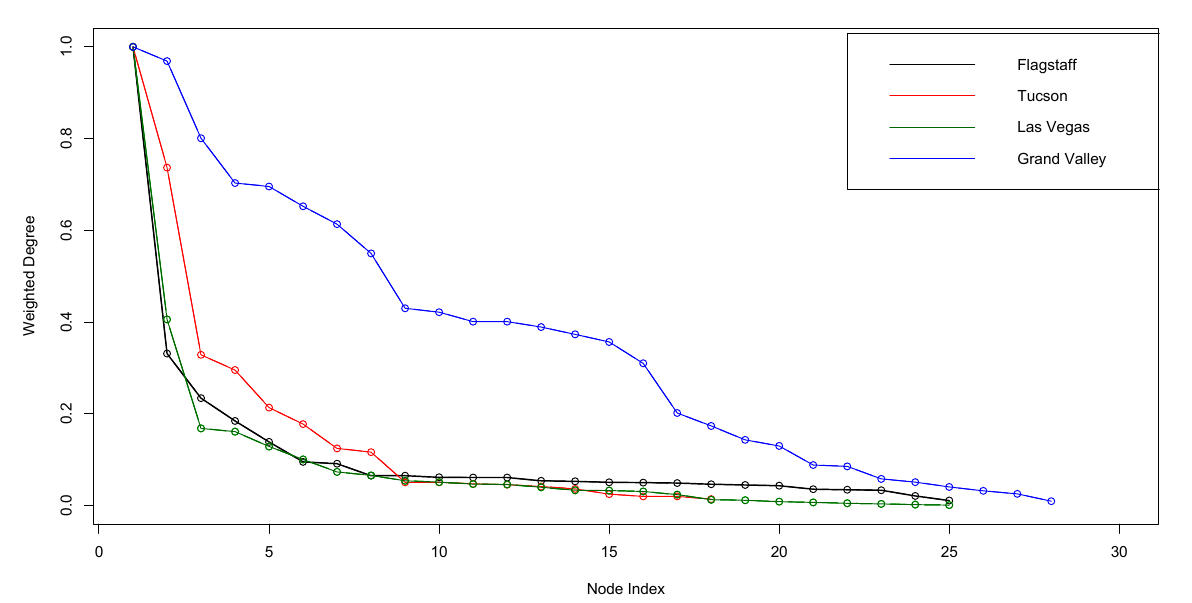
Figure 7. Normalized weighted degree distribution (sum of TF scores on common